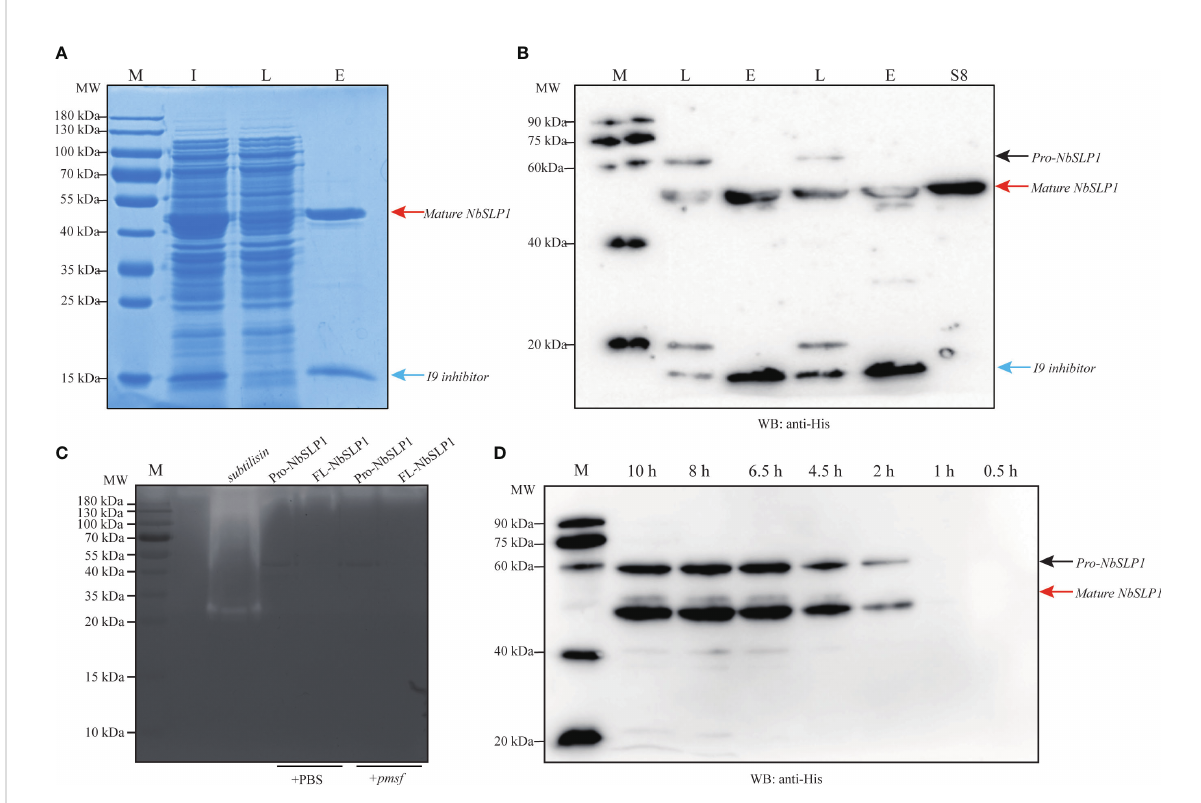
FIGURE 2 Identi fi cation of Pro-NbSLP1 autoproteolysis in E. coli. (A) SDS-PAGE analysis of Pro-NbSLP1 by pull-down assay. (B) Western blot analysis of Pro-NbSLP1 by pull-down assay. Lane M in (A) and (C) : premixed protein marker; Lane M in (B) and (D) : ECL marker; Lane I: crude lysate extracted from induced E . coli BL21 (DE3) transformed with pET30- Pro - Nbslp1 ; Lane L: Flow-through after combination with cobalt chelate resin; Lane E: Elution of Pro-NbSLP1 by Pull-down assay; Lane S8: NbSLP1-Peptidase_S8 peptide; Pro-NbSLP1 are indicated by black arrow; mature NbSLP1 are indicated by red arrows and Pro-peptide/I9 inhibitor are indicated by blue arrows. (C) Identi fi cation of enzymatic activity by casein zymography. Subtilisin was purchased from Sigma as positive control. Pro-NbSLP1 and FL-NbSLP1 adding PMSF (phenylmethylsulfonyl